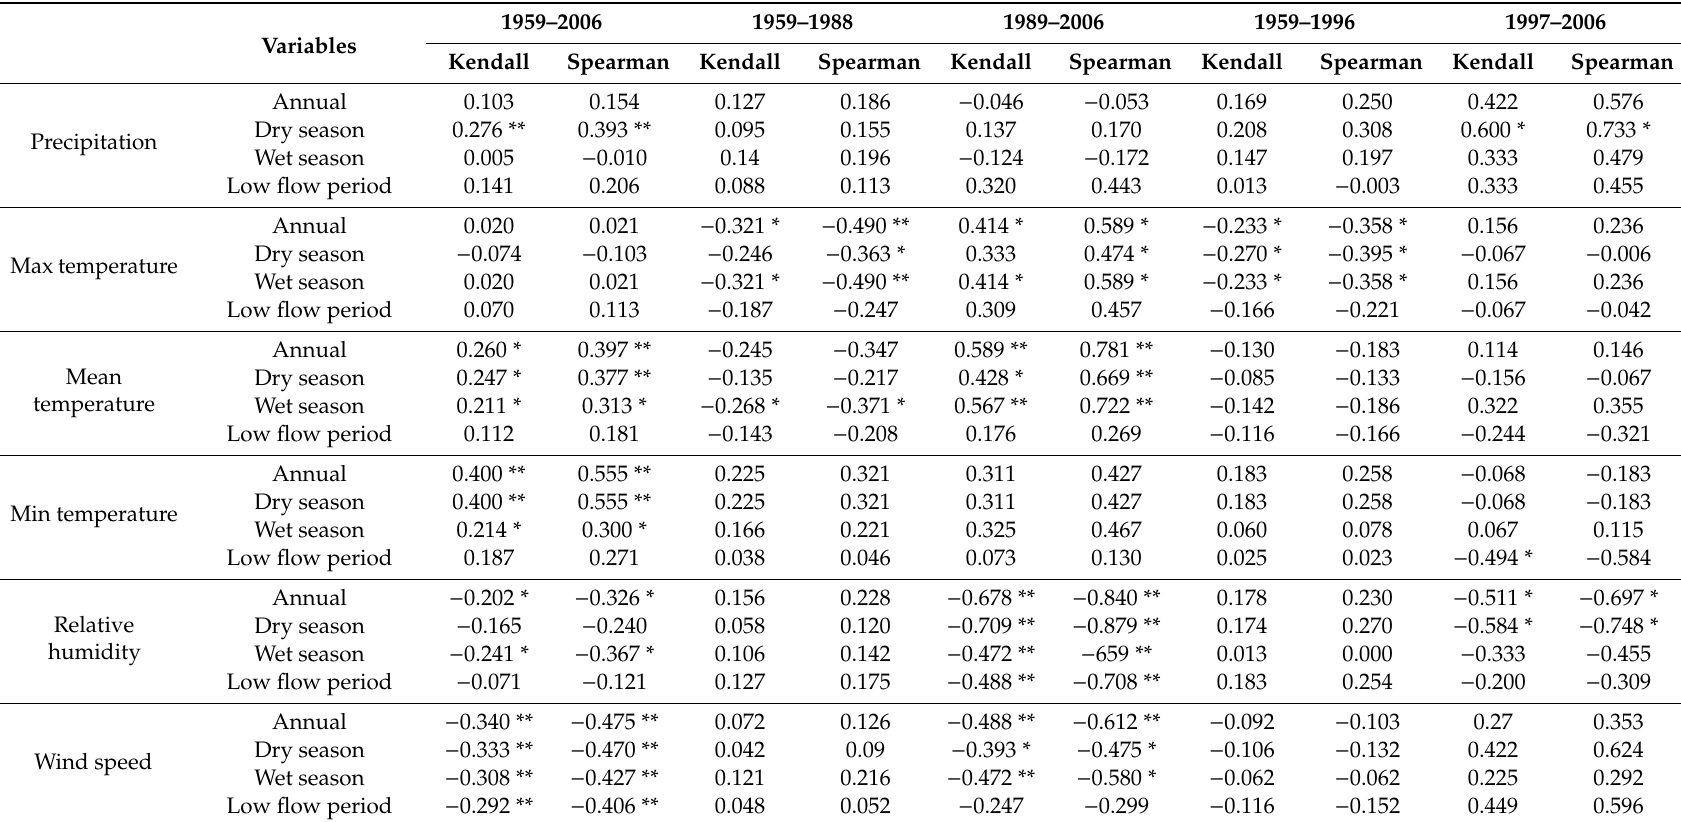
Table 4. Trend analysis for climatic